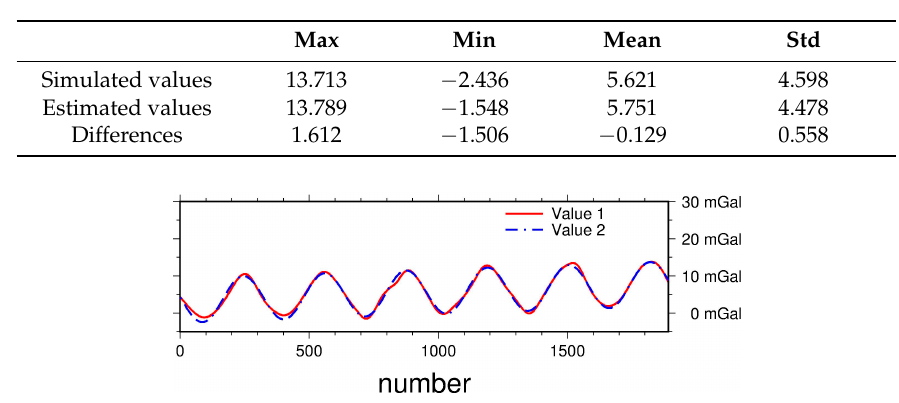
Figure 4. The systematic errors in the Tibetan Plateau (Value 1: The simulated systematic error; Value 2: The estimated systematic error from the semi-parametric model).